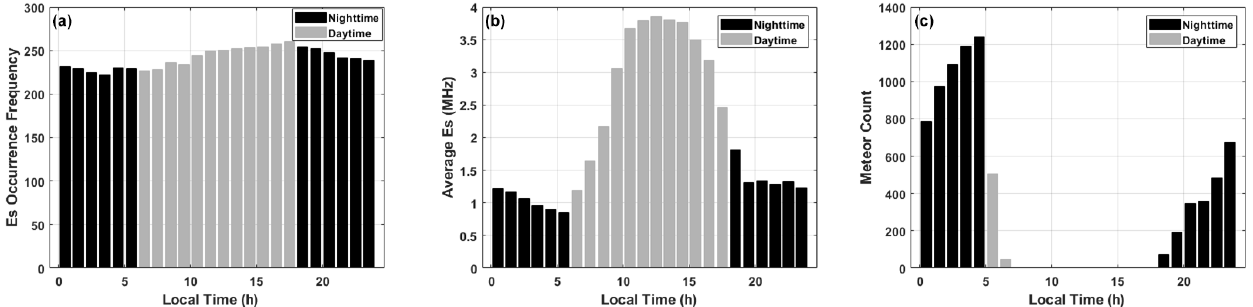
Figure 3. Simultaneous monitoring of meteors and the Es layer over the Arabian Peninsula from May 2019 to April 2020. (a) Es occurrence frequency as a function of local time. (b) Hourly average of foEs recorded using ionosonde. (b) Hourly meteor